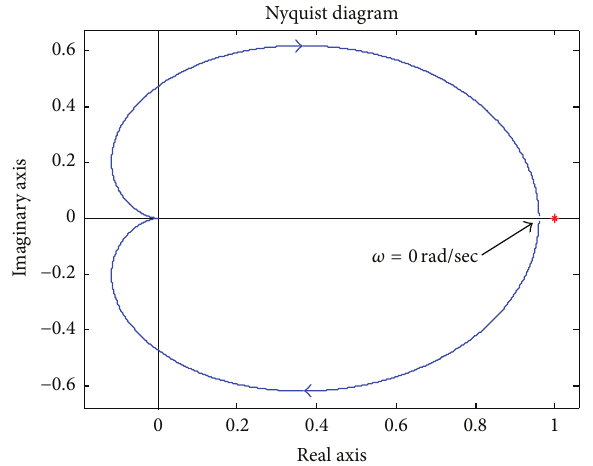
Figure 9: Nyquist plot of 𝛾 2 (𝑠) (Case 2 ).